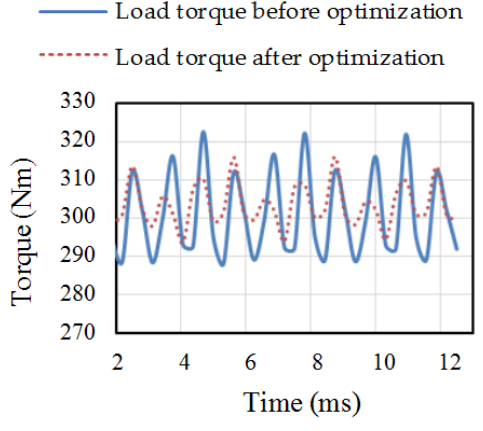
Figure 10. Torque of the AFPMSM at the rated load.